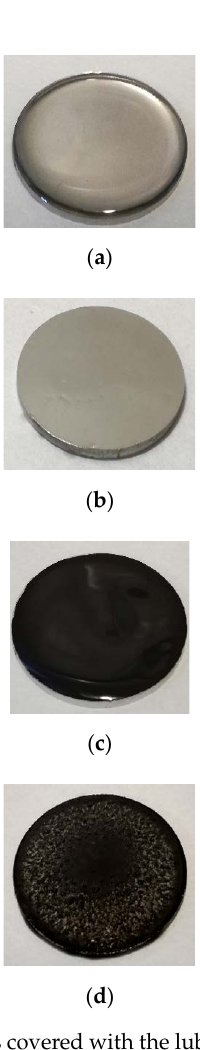
Figure 1. Photographs of AISI 316L disks covered with the lubricants before the tests: ( a ) IL; ( b ) IL spin coated thin film; ( c ) IL + G; ( d ) IL + G spin coated thin film. AISI 316L stainless steel disks and sapphire balls were used for pin-on-disk tribological tests, under the conditions shown in Table 1, and previously described for sapphire–steel IL lubrication. Table 1. Experimental conditions for pin-on-disk tests.